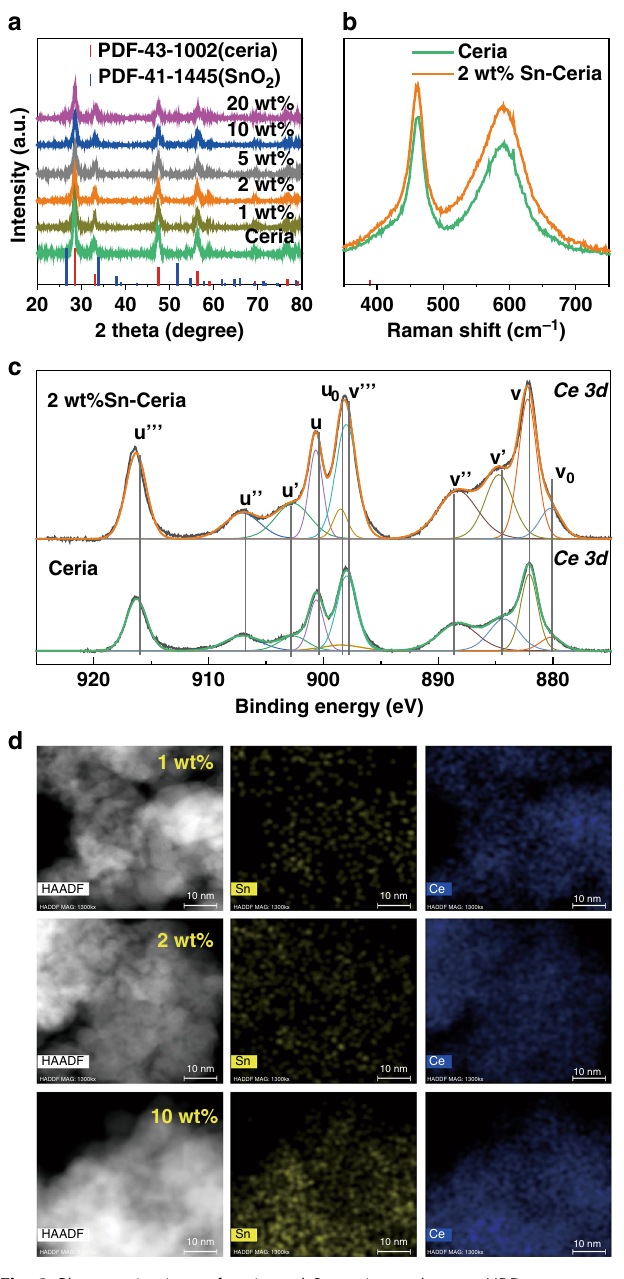
Fig. 2 Characterizations of ceria and Sn-ceria catalysts. a XRD patterns (using Cu K α radiation) of ceria and Sn-ceria catalysts with various Sn loading ranging from 1 wt% to 20 wt%. b UV-Raman spectra of ceria (green line) and 2 wt% Sn-Ceria (orange line). c XPS spectra for Ce 3 d core level of pristine ceria and 2 wt% Sn-ceria. d TEM and EDS elemental mapping images (Ce and Sn) of 1 wt%, 2 wt%, and 5 wt% Sn-ceria catalysts. Scale